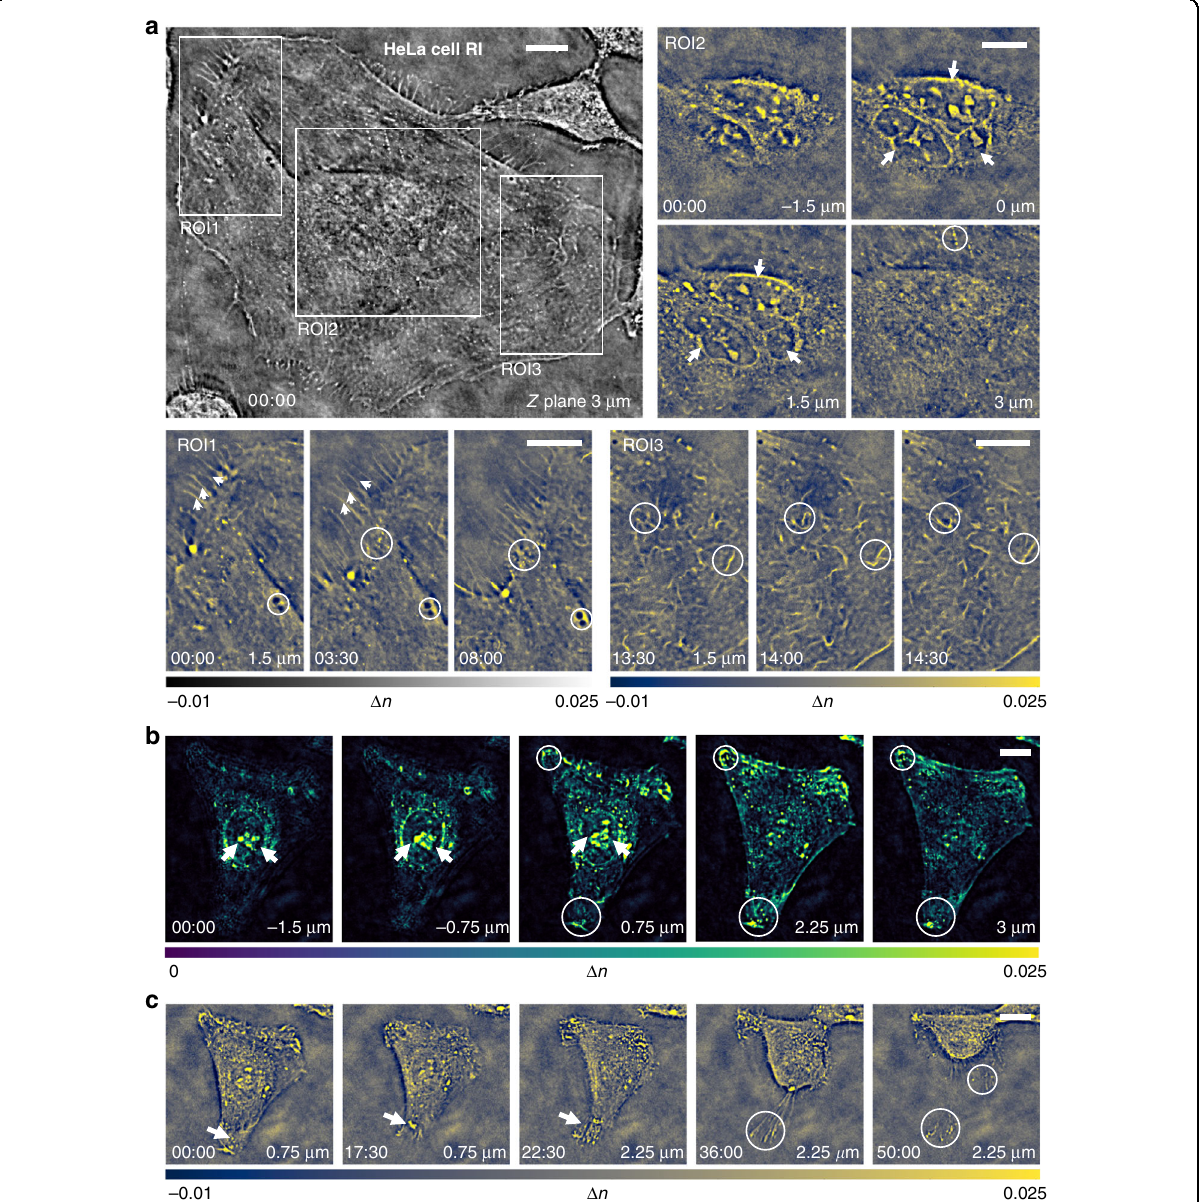
Fig. 5 HeLa cells 3D RI imaging over hour-long time-lapse. a Recovered RI slice of trinucleated HeLa cell located at 3 µm Z plane at the start time point of 00:00:00, and enlarged time-lapse tomographic RI image of three different ROIs in the FOV. The whole process of HeLa cells visualization is given in Video S9. b Maximum intensity rendering of HeLa cell in another ROI located at different axial planes at the start time point of 00:00:00. c Cross-sectional view of the RI tomogram in the ROI at fi ve different time points and axial planes. Scale bars: 15